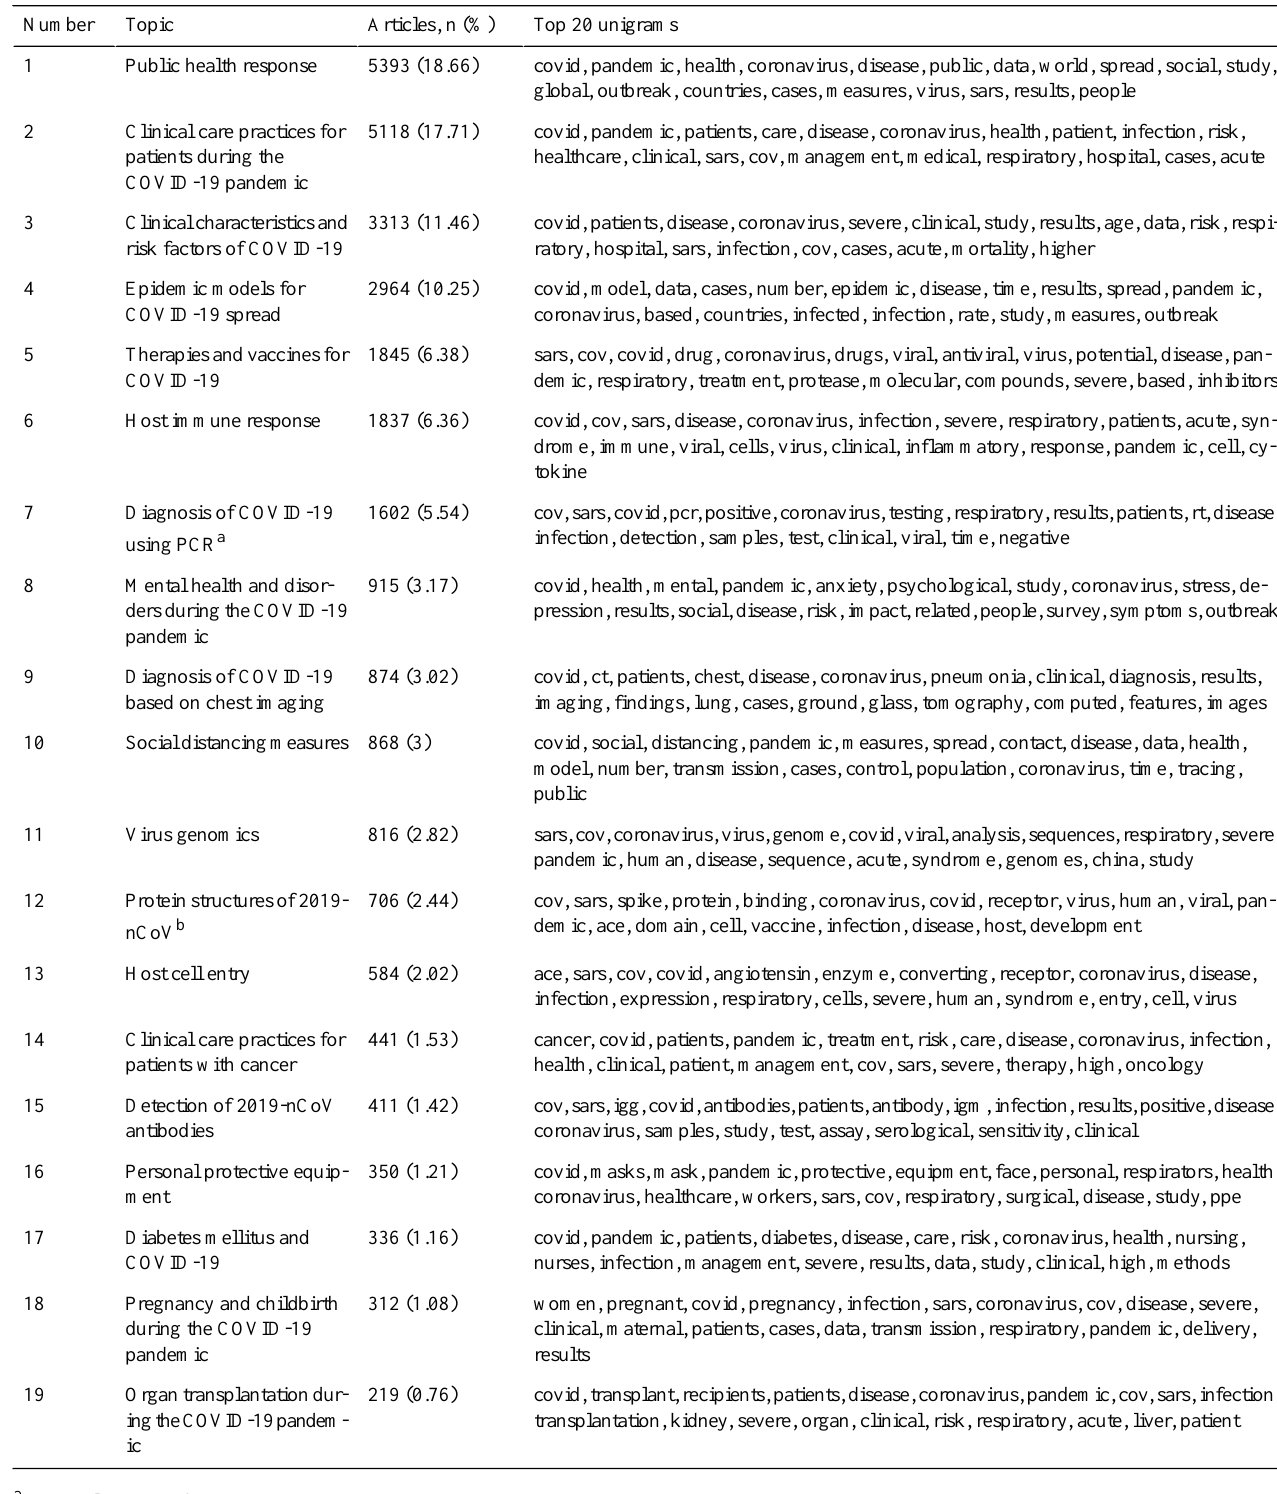
Table 5. COVID-19–related topics addressed by the included publications (N=28,904).